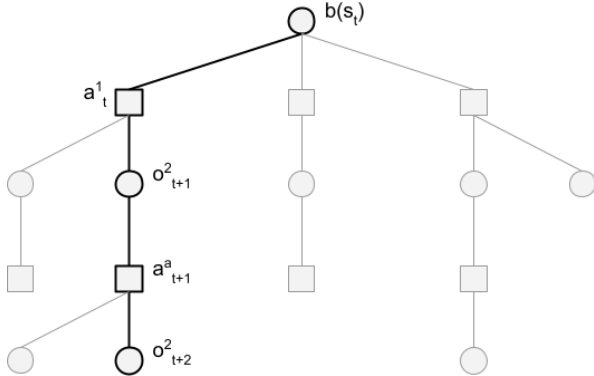
Figure 5. Monte Carlo search tree. Each simulation in an MCTS algorithm is encoded into a search tree. The example tree is rooted at the belief, b(s t ) , given at the start of search. Paths from the root to a leaf of the tree represent a simulated trajectory of alternating actions, a i t , and observations, o i t . An example trajectory in the tree is shown in